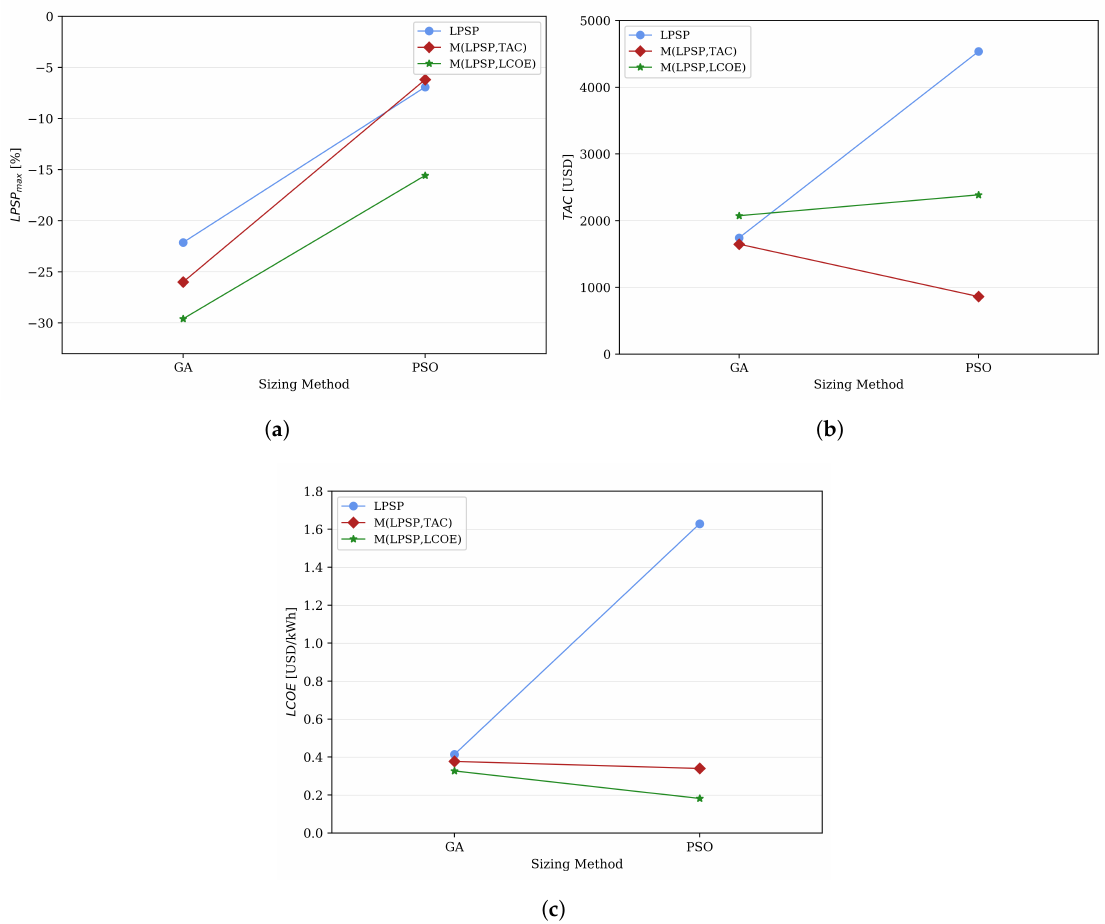
Figure 5. Interaction factors for Case II: demand of non-interconnected zone with water